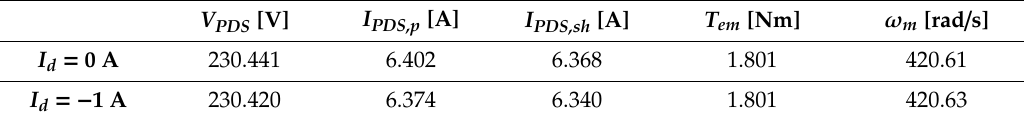
Table 9. Average values at the first working point for di ff erent I d values.